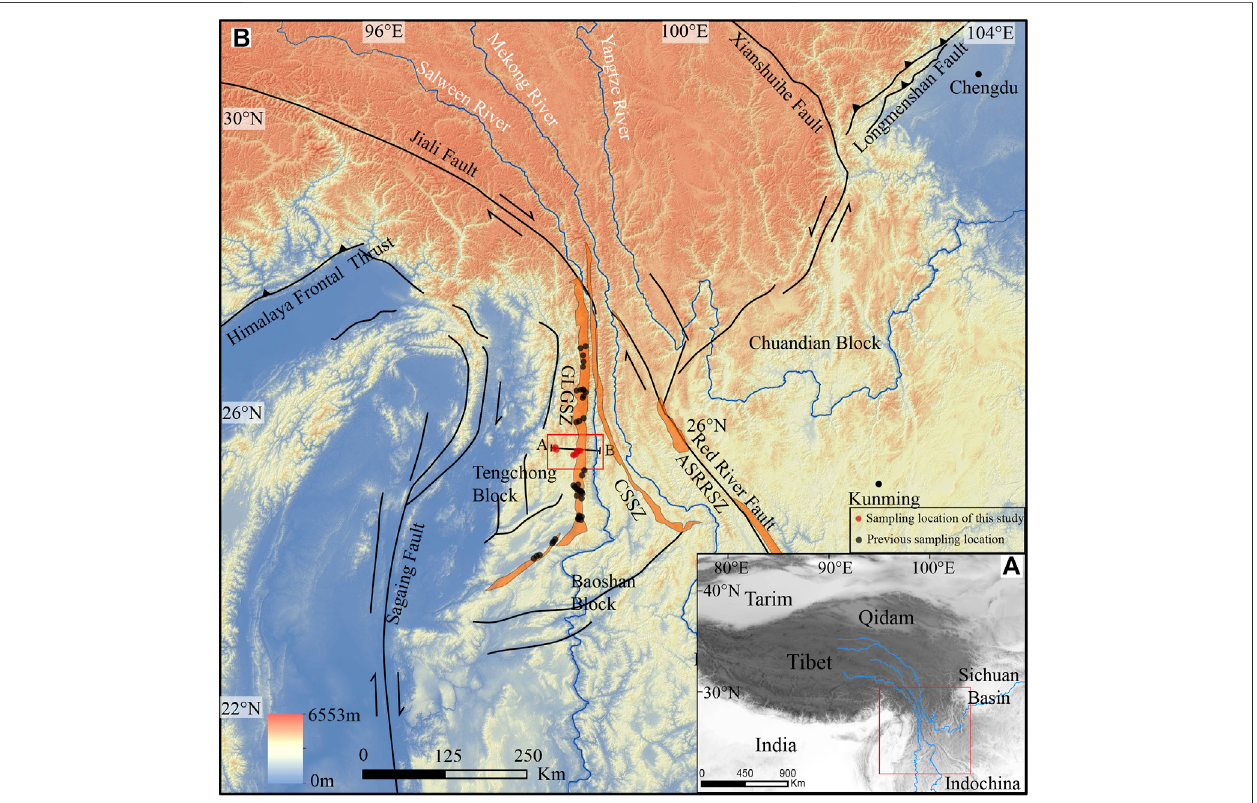
FIGURE 1 | Tectonics and regional topography of the Three Rivers Region and surrounding areas. (A) Simpli fi ed tectonic framework of the Tibetan Plateau. Modi fi ed from Deng et al.(2014). (B) Digital elevation model (DEM) ofthe topographyand active faults in the Three Rivers Region, showing the study area(red rectangle) and samplelocationsinthisstudy(redcircles).DEMdataisbasedon~90 mShuttleRadar Topography Mission(SRTM).Previous thermochronologicalagesmarkedby darkcirclesarealsoshown(Akciz,2004;Wangetal.,2008;Linetal.,2009;Songetal.,2010;Zhangetal.,2012;Liuetal.,2015;Xuetal.,2015;Tangetal.,2016; Zhangetal.,2017;Wangetal.,2018;Tangetal.,2020).GLGSZ:TheGaoligongshearzone;CSSZ:Chongshanshearzone;ASRRSZ:Ailaoshan – RedRiversheerzone. Red square is the study area shown in Figure 2 .